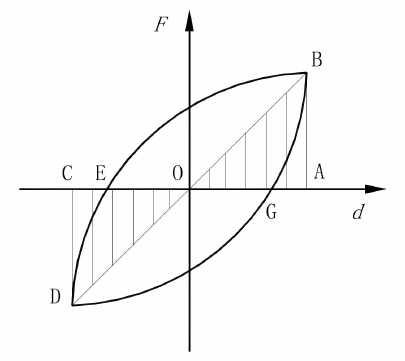
Figure 11. Calculation of the energy dissipation coefficient.